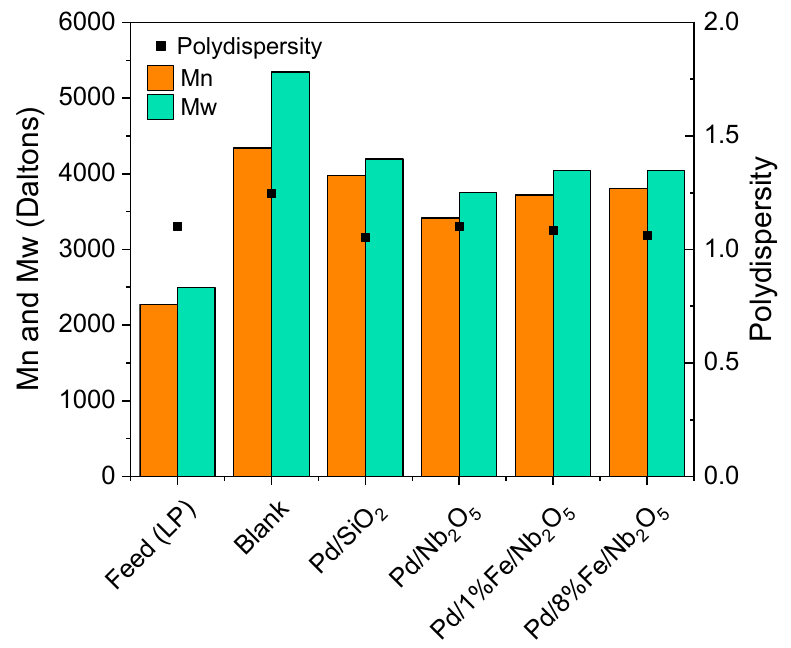
Figure 6. Average molecular weight and polydispersity of upgraded oils in comparison to the feedstock.